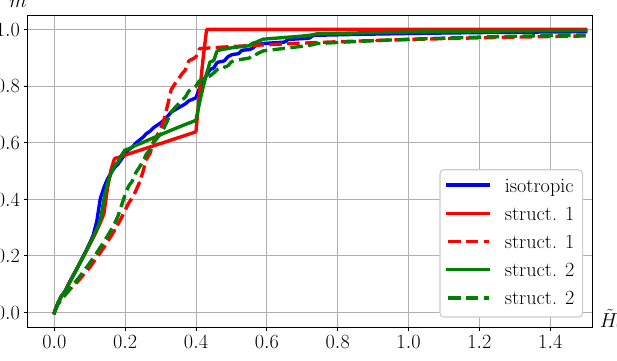
Figure 9. Magnetization curves for different polycrystals: isotropic and texture-oriented (structure 1 and structure 2). The solid lines show the magnetization curves for polycrystals when an external magnetic field is applied along the k 1 vector of these polycrystals. The dashed lines show the magnetization curves for textured polycrystals when a magnetic field is applied at an angle of 45 ◦ to vector k 1 of these